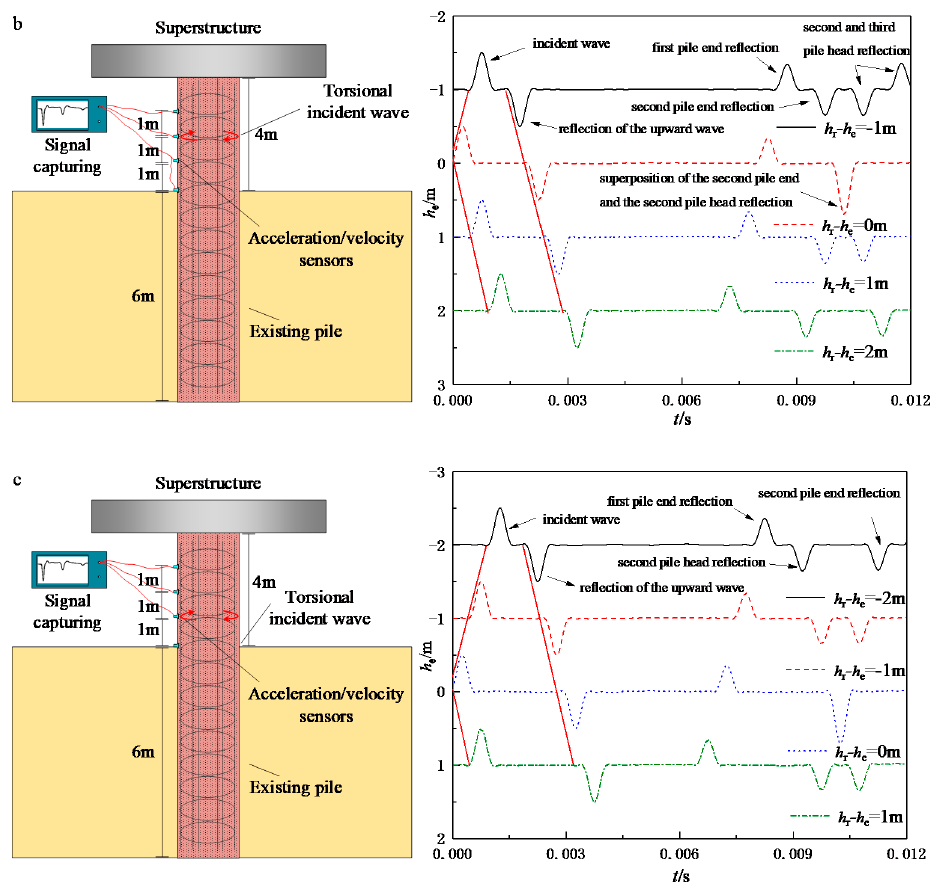
Figure 5. Influence of the layouts of the input and signal receiving locations on the TLSIT spectrums: ( a ) h e = 1 m; ( b ) h e = 2 m; ( c ) h e = 3